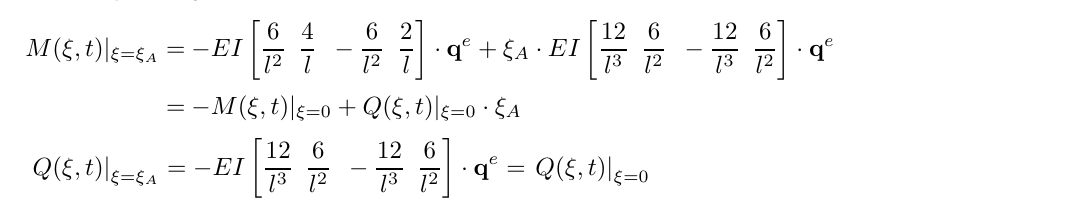
Fig. 1. Sectional forces diagram for the cross-section at any point in a Bernoulli-Euler beam element in the dynamic analysis. written as,